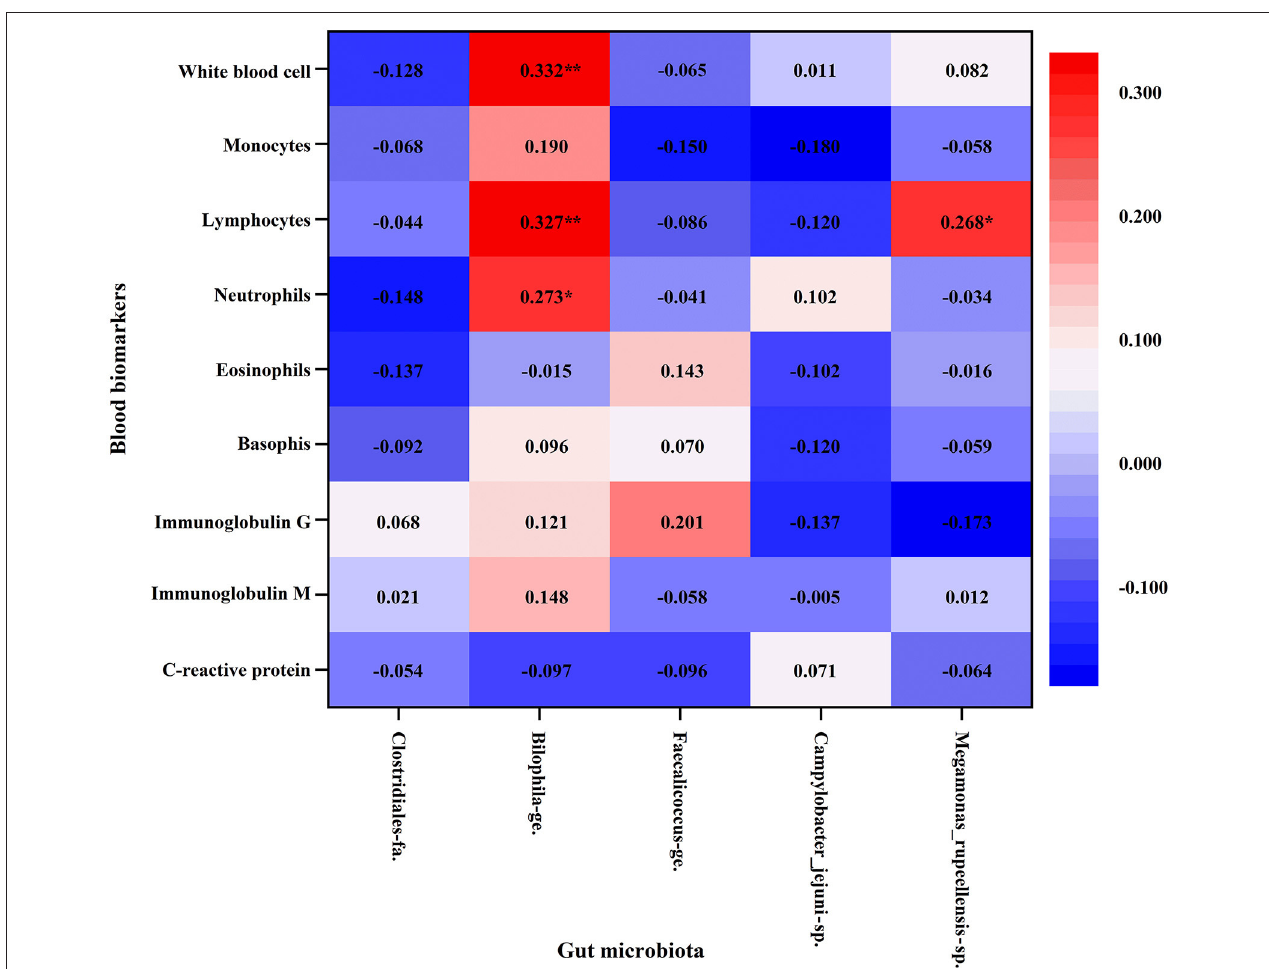
FIGURE 4 | Association between blood biomarkers of immune function and gut microbiota with Pearson’s correlation analysis. Athlete, Athlete group; HPA, High physical activity group; LPA, Low physical activity group. * p < 0.05; ** p < 0.01.